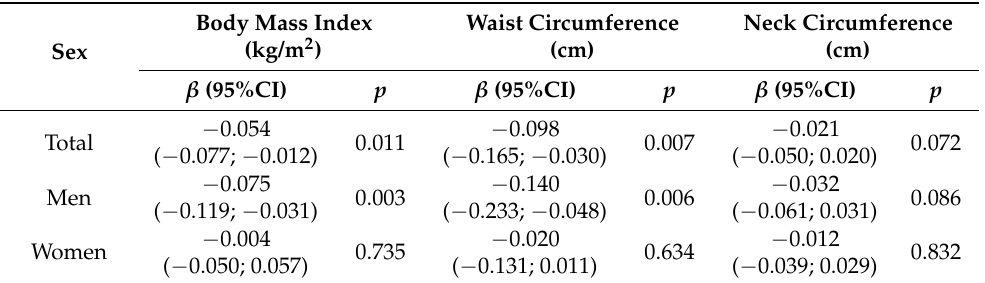
Table 4. Multilevel linear regression models ( β coefficient, 95%CI) between device-measured daily step and adiposity indicators stratified by